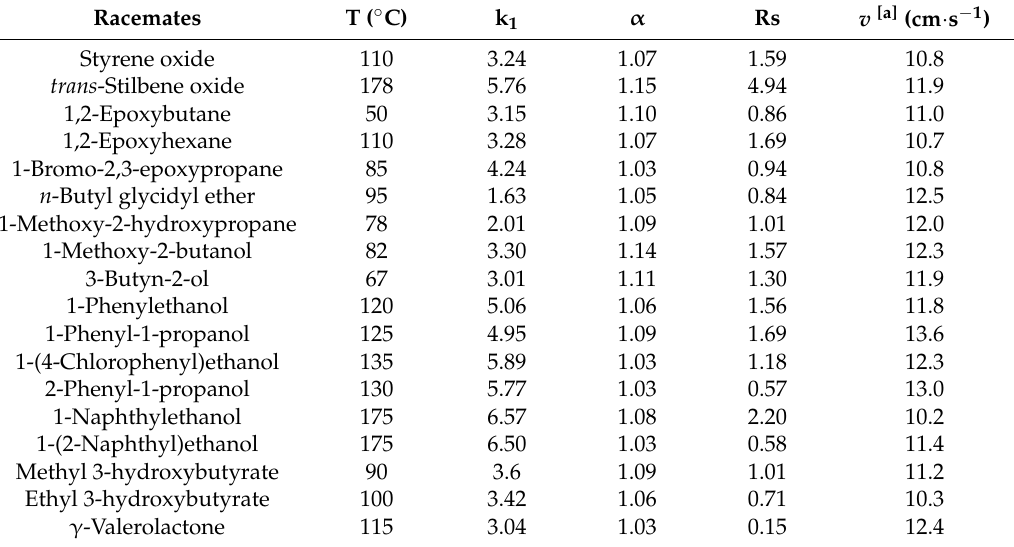
Table 3. Separation of racemates on the pentyl cage-coated capillary